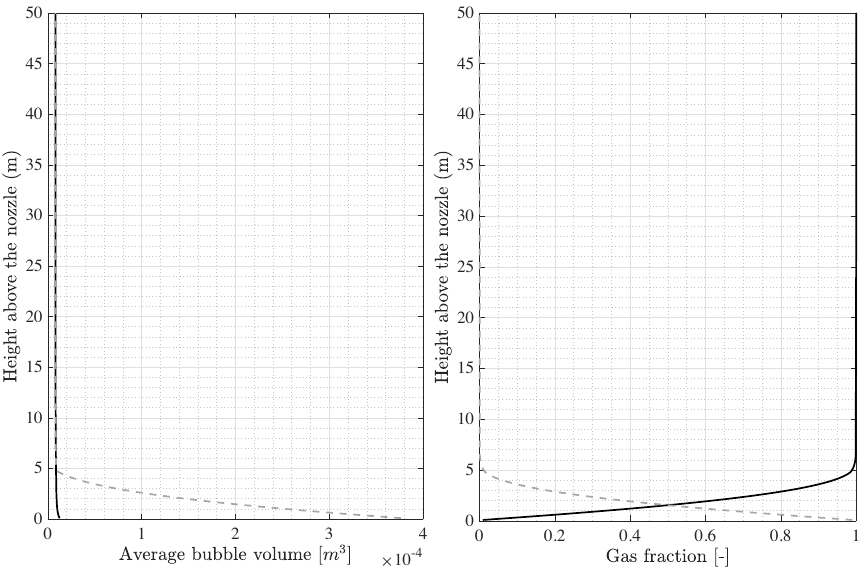
Figure 6. Computed depth-dependent variables for the case of the air flow rate being 0.024 m 3 /s: ( left ) the arithmetic mean bubble volumes and the ( right ) gas fraction ratio ( (cid:101) gmi the depth, in which the black solid line indicates the results for small bubbles and gray dashed line represents the results for large bubbles.